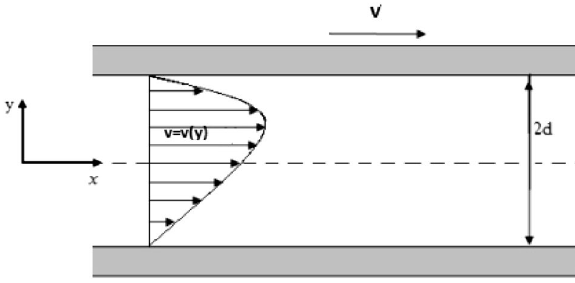
Figure 1. Geometry of generalized plane Couette